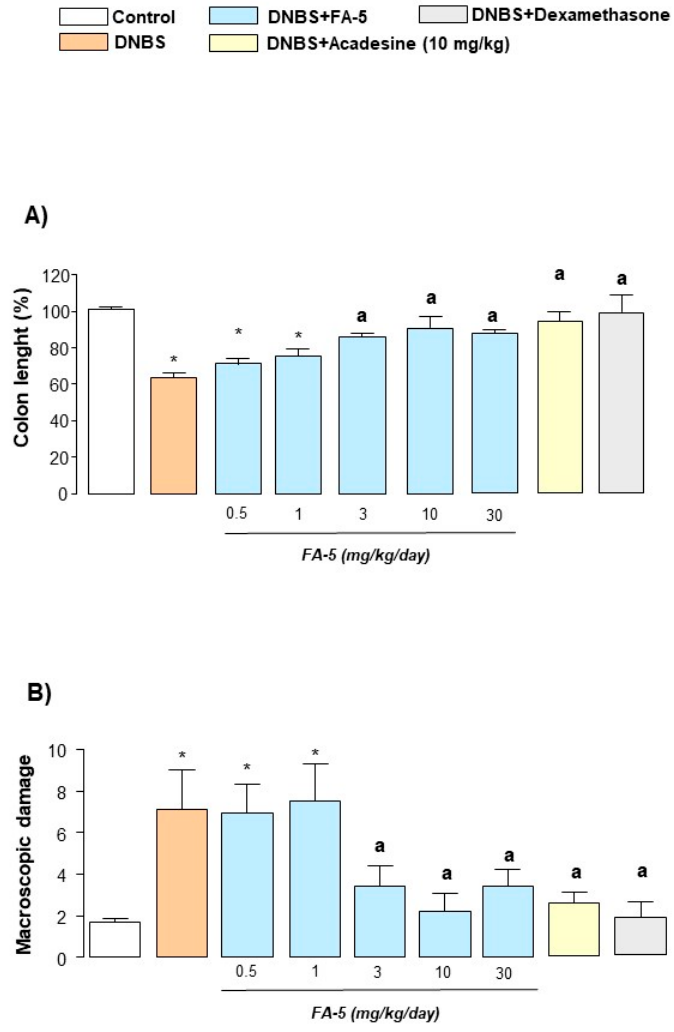
Figure 3. Colonic length ( A ) and macroscopic damage score ( B ) evaluated in rats with colitis, either in the absence or in the presence of FA5 (0.5, 1, 3, 10, 30 mg/kg/day), acadesine (10 mg/kg/day), or dexamethasone (0.1 mg/kg/day). Each column represents the mean ± standard error of the mean (SEM) ( n = 8). *, p < 0.05, significant difference versus control group; a , p < 0.05, significant difference versus DNBS group.